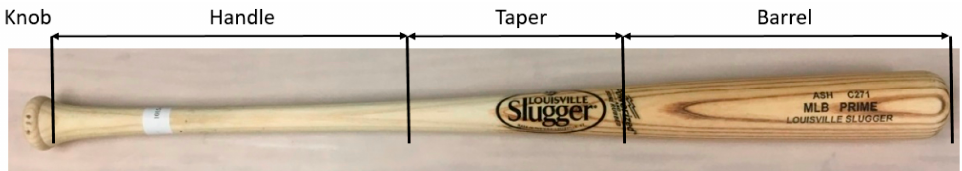
Figure 1. The four sections of a baseball bat.